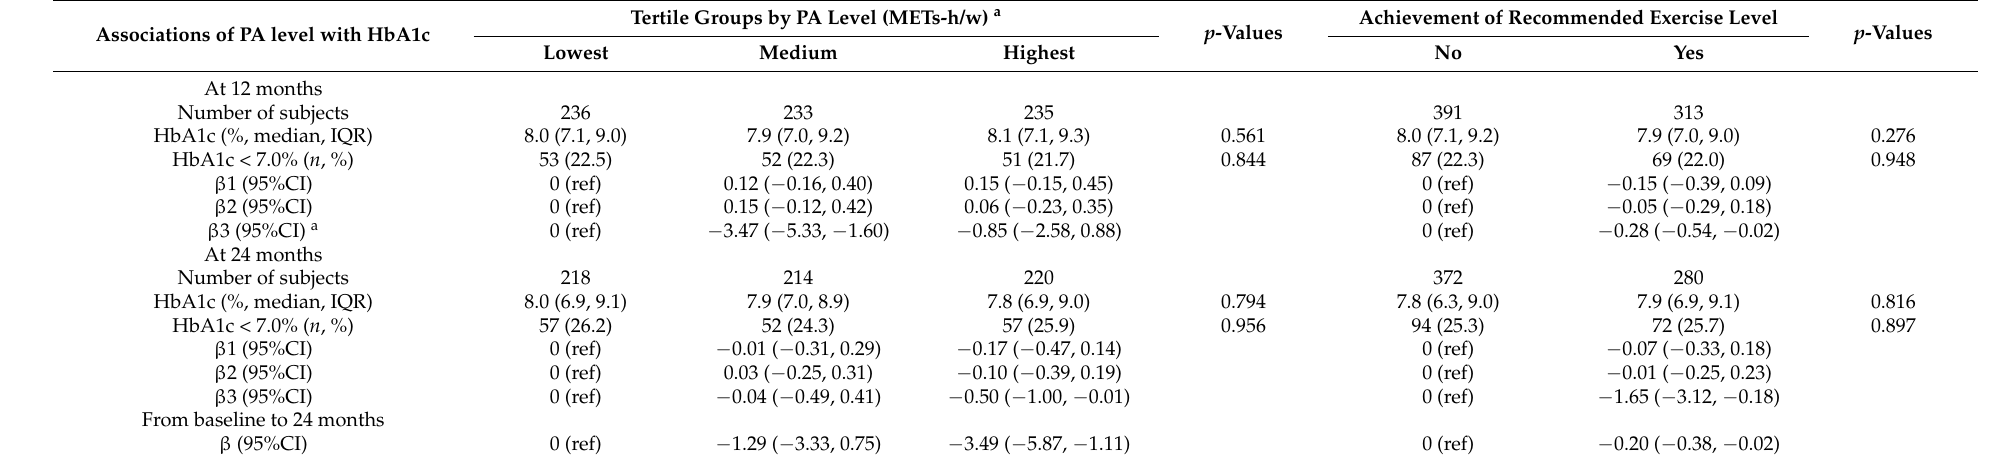
Table 4. Associations of PA level with improvements in HbA1c among the study